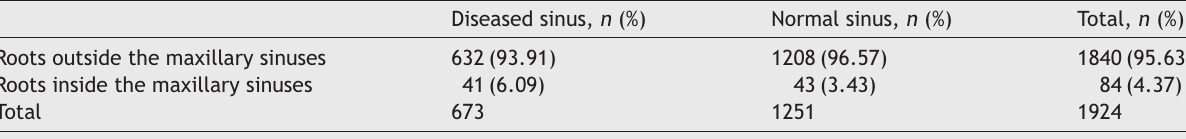
The sinus cavities were classified as diseased or normal. The tooth roots were considered to be inside or outside the sinus. Number of roots inside and outside diseased and normal maxillary sinuses.